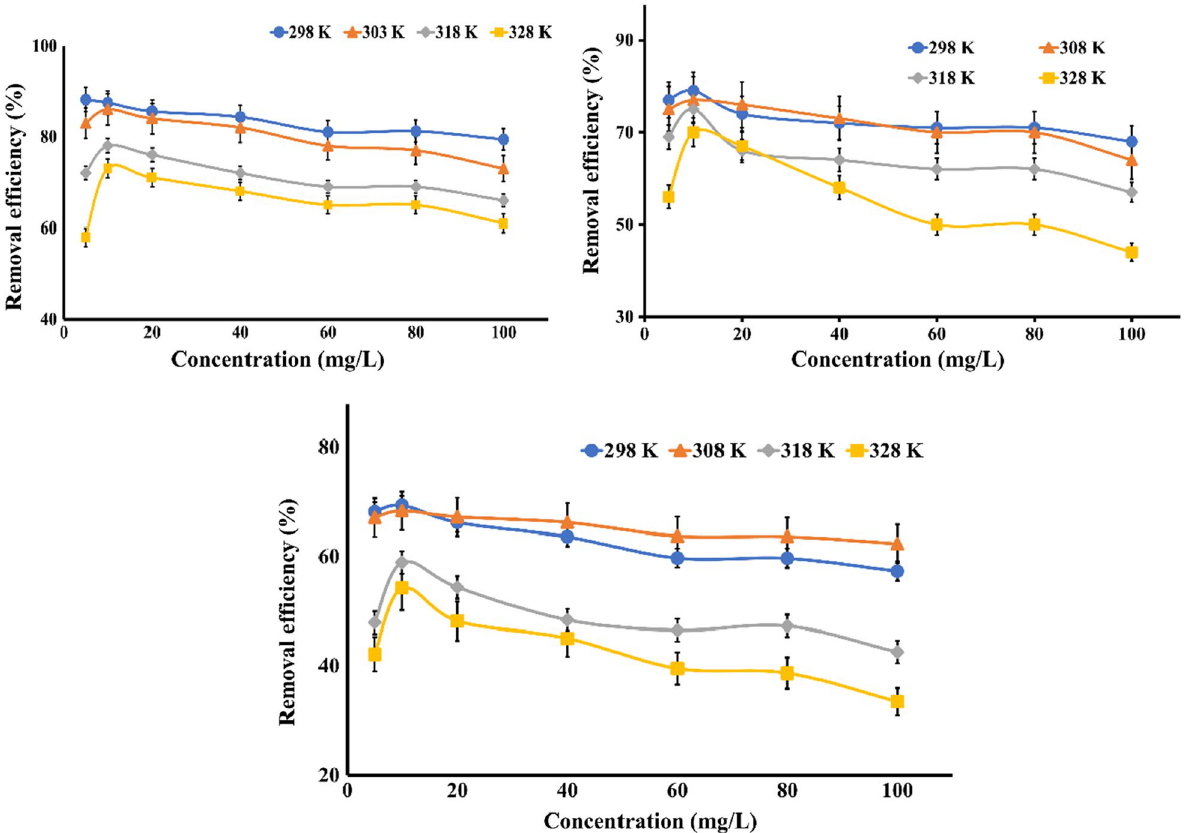
Fig. 9 Effect of initial concentration and temperature on removal of a 2,4-DNP, b 2,4-DCP, and c BPA onto Fe 3 O 4 @MAA-βCD. Conditions: (298 K, 10 mL of analyte solution at pH 2, 7, and 6, 20 mg sorbent dose, at 250 rpm shaking